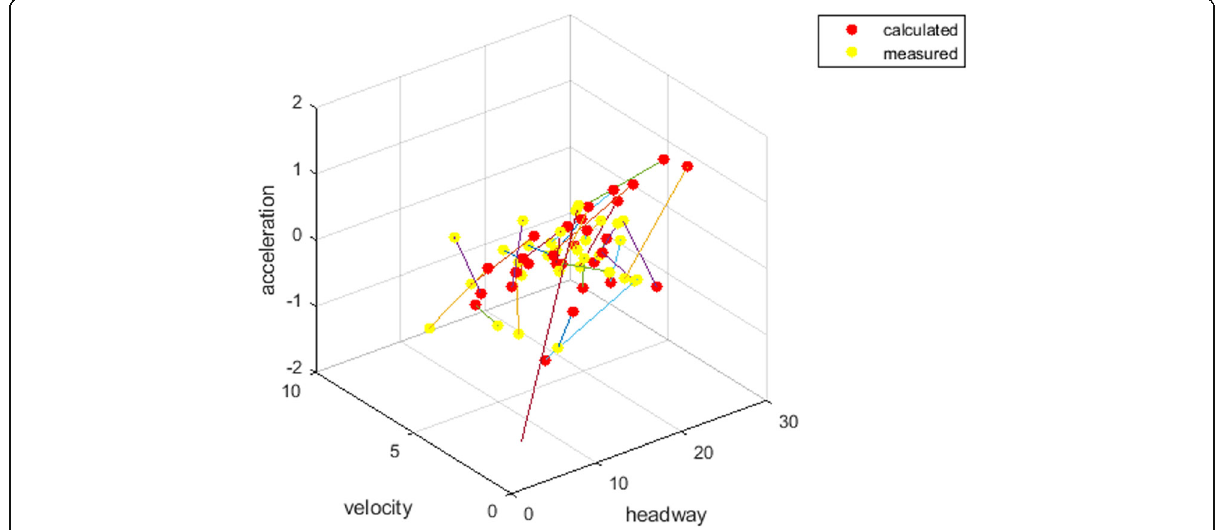
Fig. 5 comparison of the calculated and measured values in the case of 10%